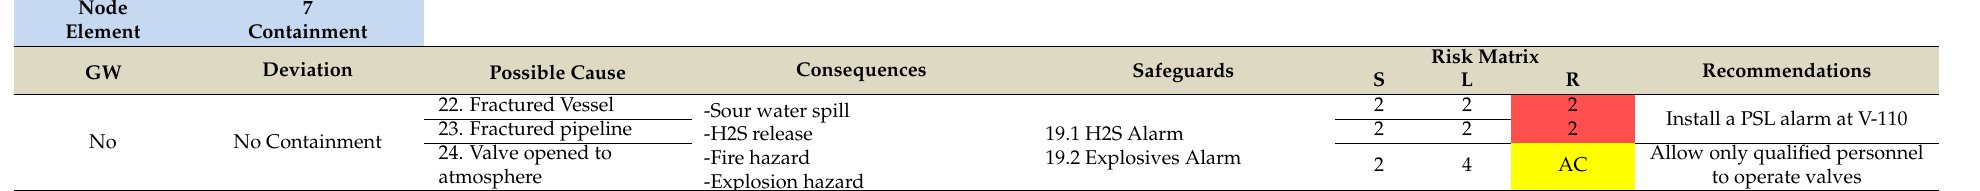
Allow only qualified personnel to operate